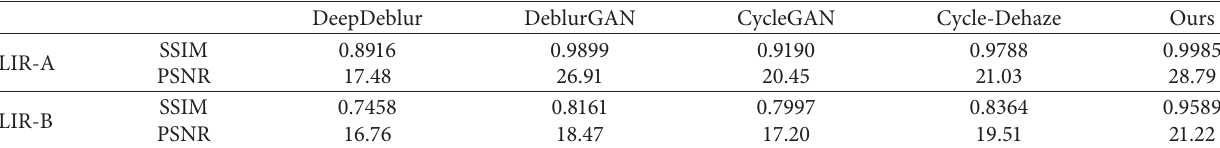
Table 4: Comparison of the deblurring performance of various methods on different types of blurred images.